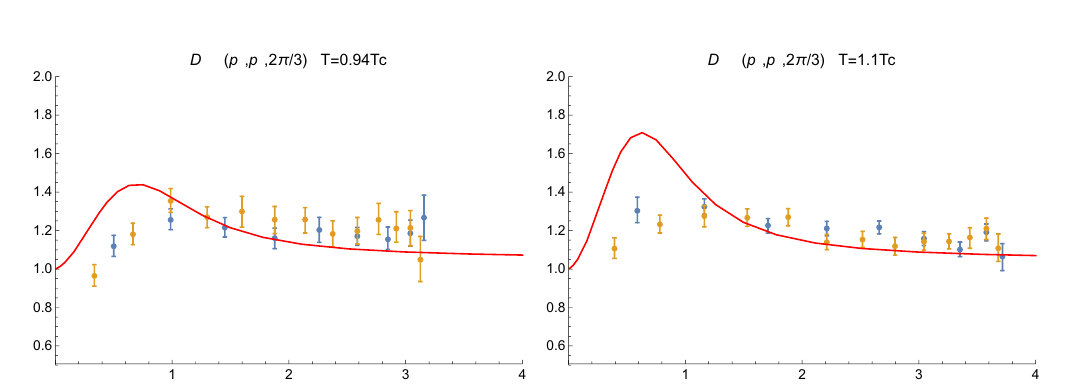
Figure 6. Ghost-gluon vertex dressing function at the symmetric point in comparison to lattice results [30].